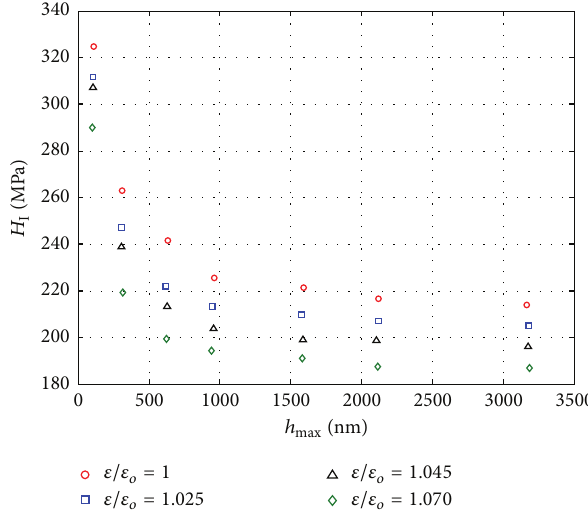
Figure 10: Indentation hardness of prestrained epoxy (20 phr) where 𝜀 and 𝜀 o are, respectively, prestrain level and initial uniaxial yield strain